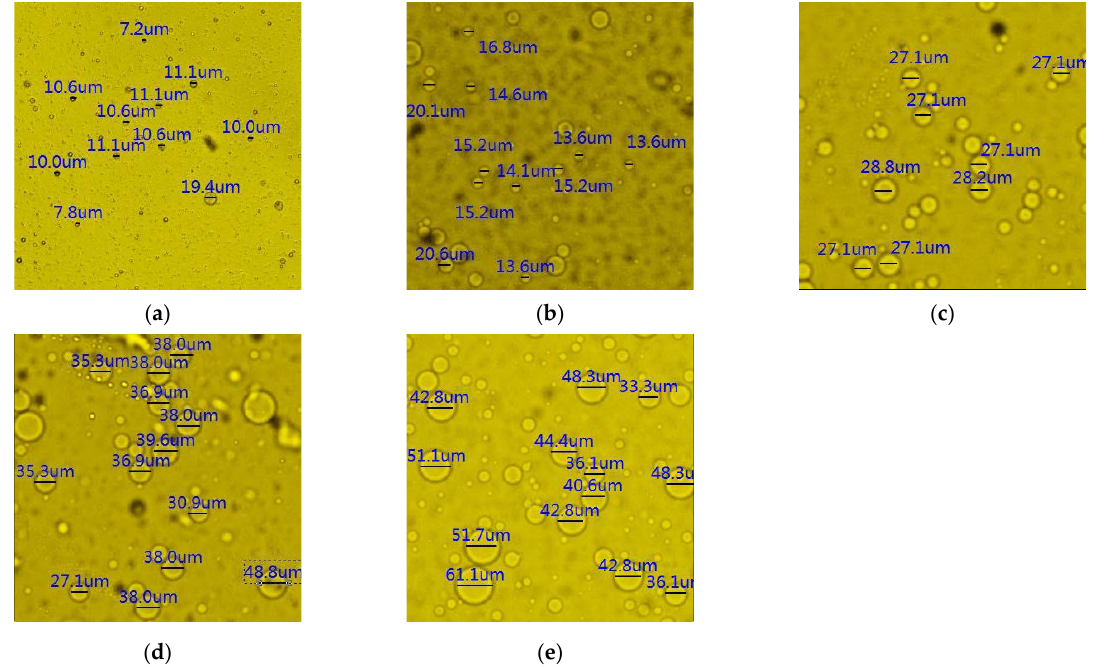
Figure 6. Polymer microsphere appearance at different hydration times: ( a ) initial, ( b ) after 1 day, ( c ) after 3 days, ( d ) after 5 days, ( e ) after 7 days. Table 4. Relationship between polymer microsphere particle size and hydration time.